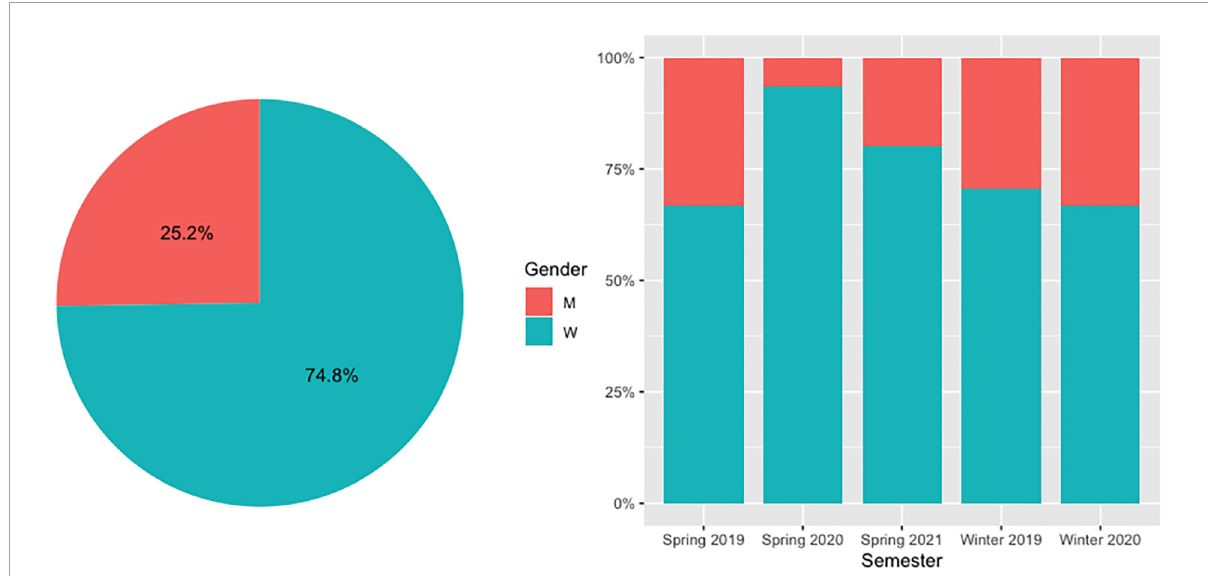
FIGURE1 Percentage distribution of the Senior Food Industry Engineering students by gender (Left) . The total proportion of the male and female students by gender during the five academic semesters evaluated (Right) (M, Men; W, Women).